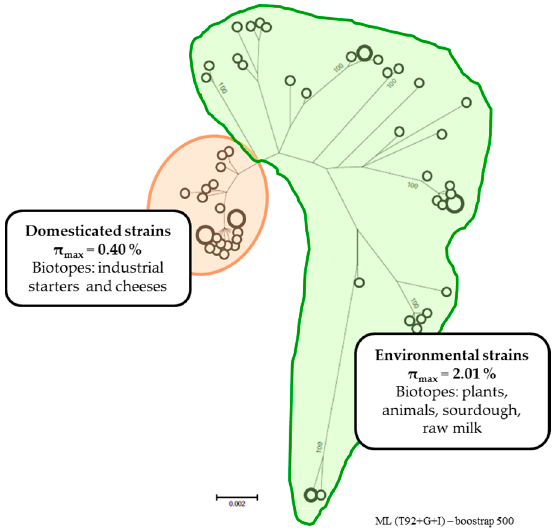
Figure 1. The two phylogenetic groups of the Lactococcus lactis subsp. lactis . The unrooted maximum likelihood tree (bootstrap 500, Tamura 3-parameter model) was constructed from the concatenated sequences of the six loci of MLST scheme from [41]. Open circles correspond to the different sequence type (ST). The size of the circles is proportional to the number of strains.